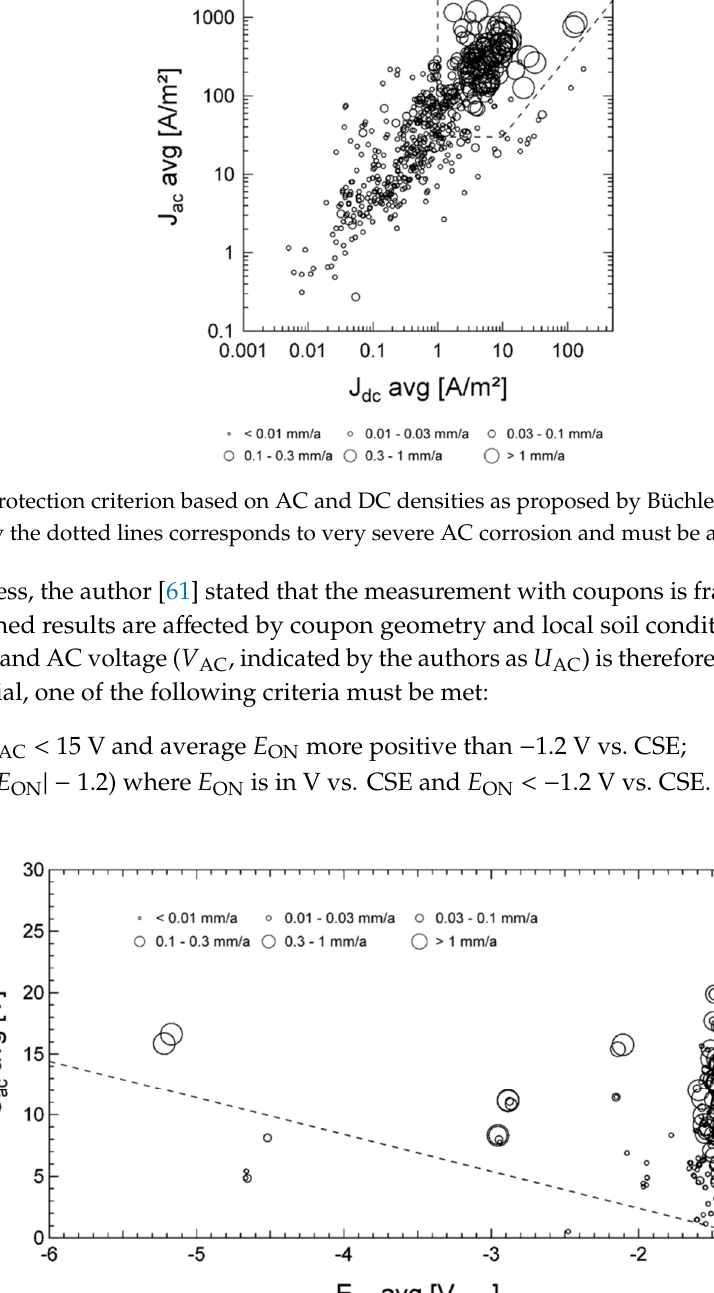
( b ) Figure 9. Graphical representation of the AC protection criteria reported on ISO 18086 [4]: ( a ) i AC vs. i DC , ( b ) V AC vs. E ON .